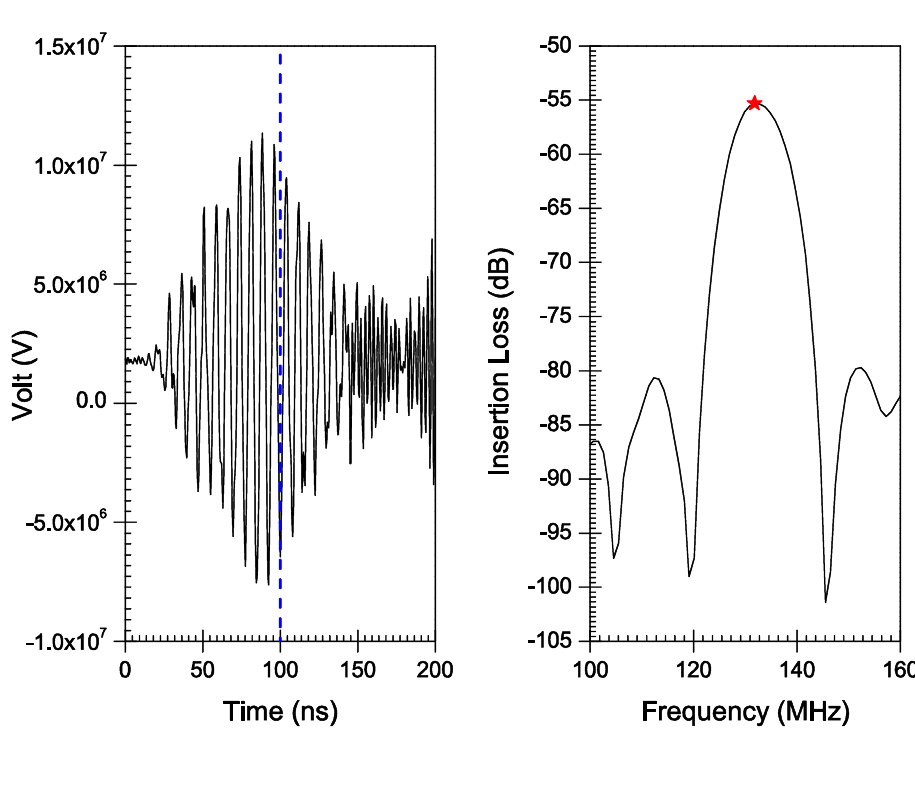
Figure 7. Time and frequency response for h /λ =